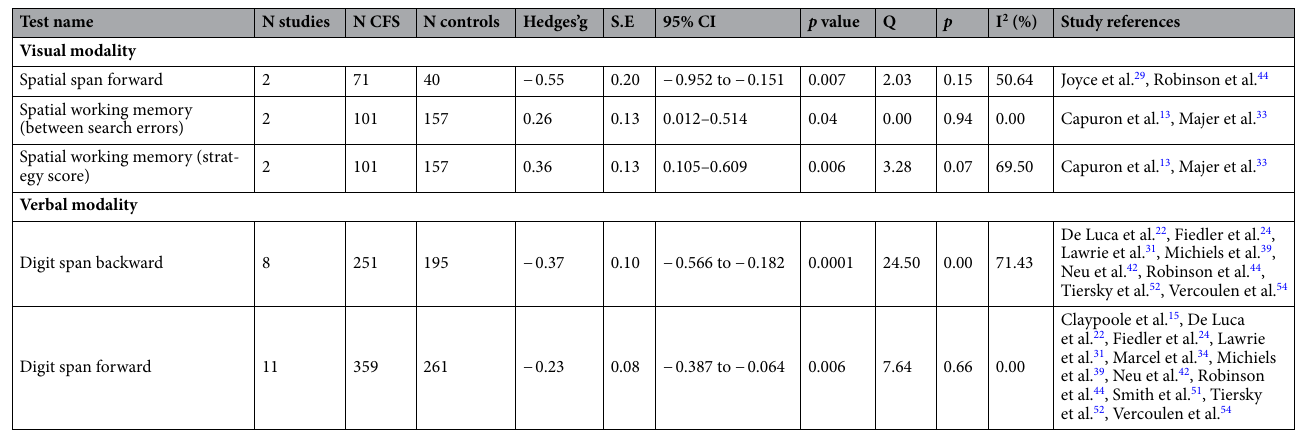
Table 7. Short-term memory: Hedge’s g effect sizes for each test, in descending order. ME/CFS myalgic encephalomyelitis/chronic fatigue syndrome, N